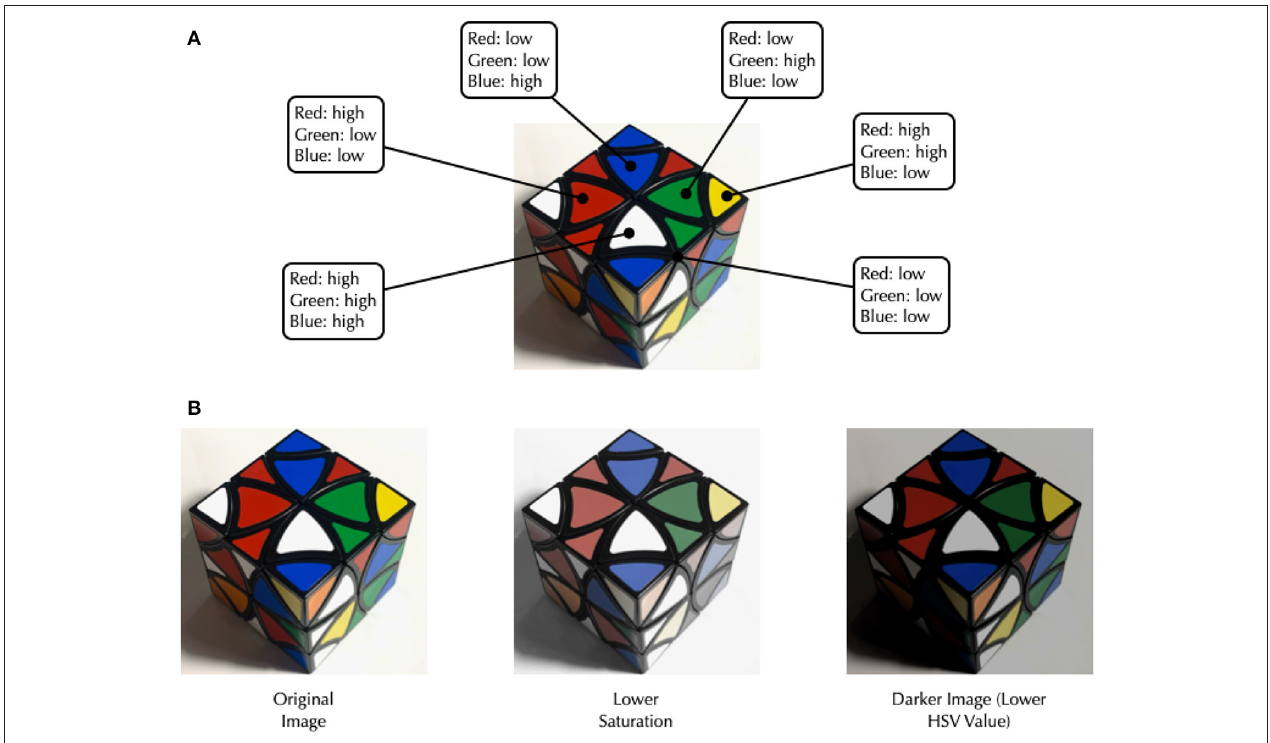
FIGURE 1 | Illustration of color characteristics in images. (A) Illustration of the red-green-blue RGB color space. (B) Illustration of lower saturated and darker images.